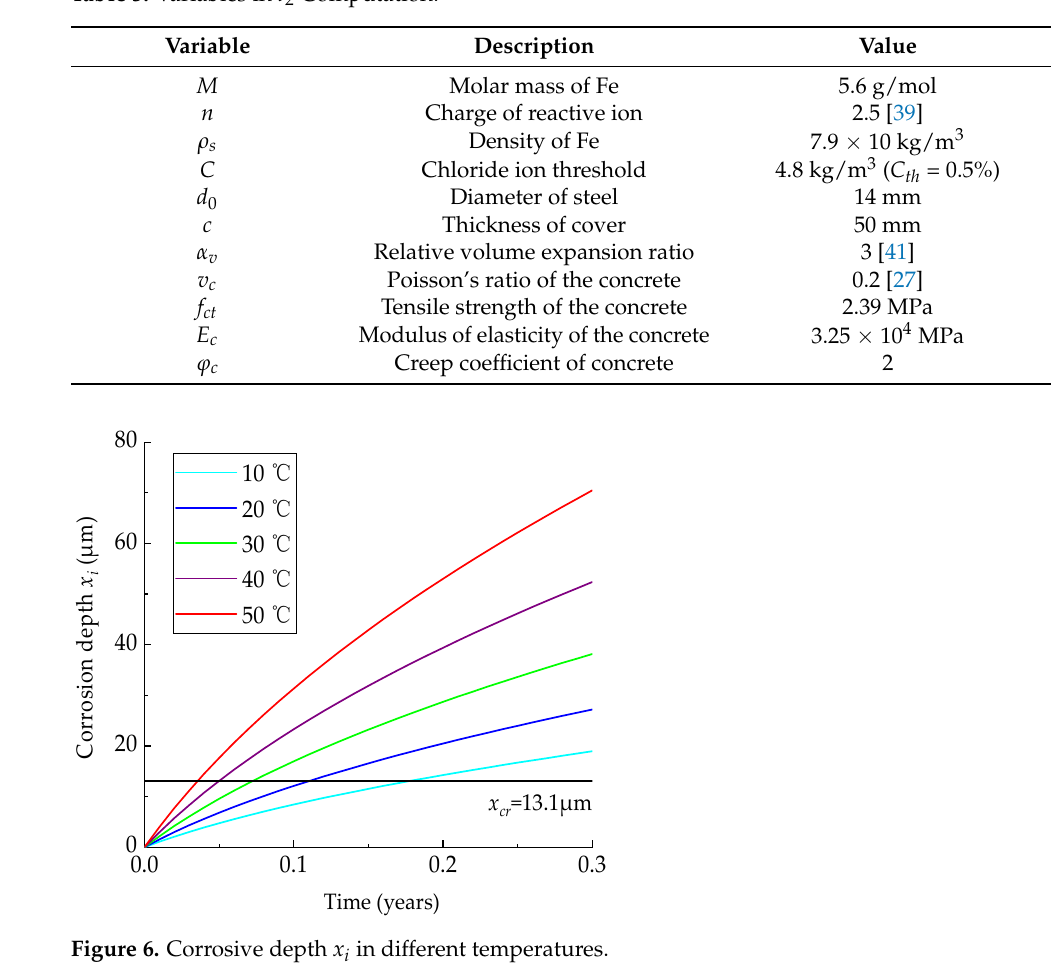
Figure 7. Schematic diagram of a single pile and loadings.